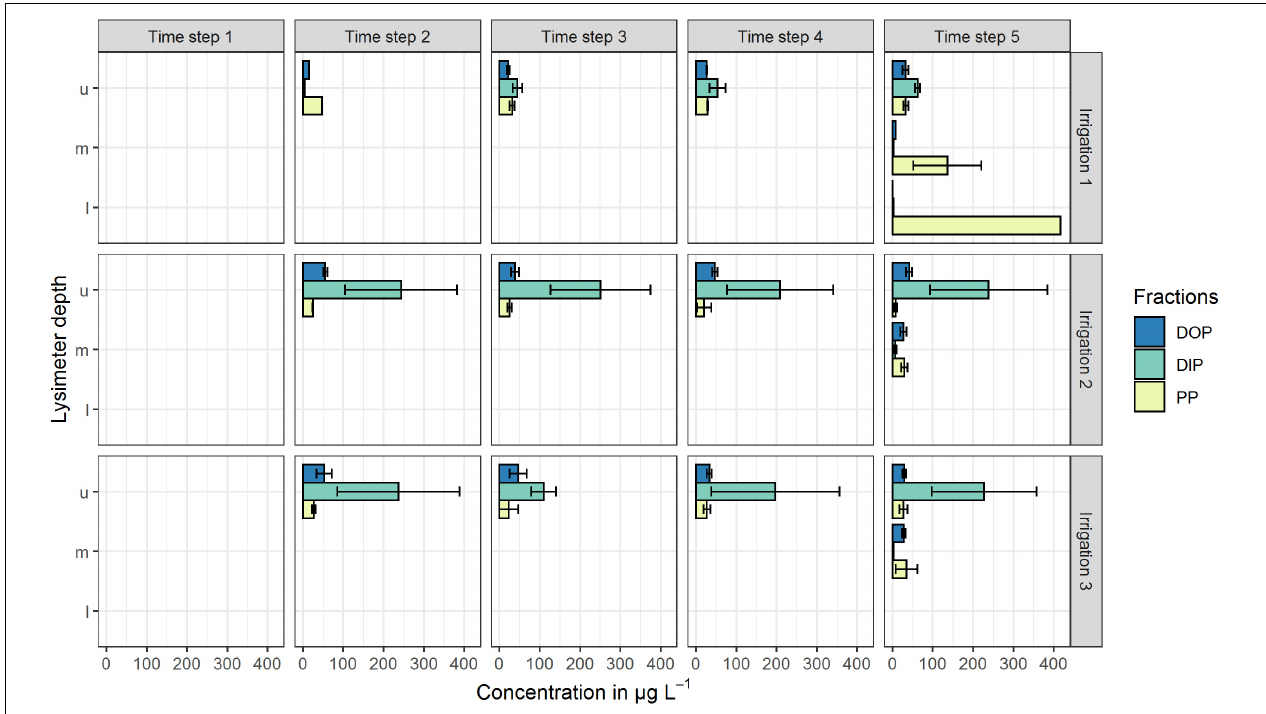
FIGURE 3 | Mean P concentrations in preferential-flow water collected with zero-tension lysimeters during three irrigations at the low P site. Arithmetic means were calculated from all samples drawn in the respective time step. Shown P fractions are DOP (dissolved organic P), DIP (dissolved inorganic P) and PP (particle bound P). Lysimeter depths are indicated by u (upper), m (middle) and l (lower). Time steps 1–4 each represent 60 min of irrigation, time step 5 represents 180 min after the end of the irrigation. No bar indicates that in the respective time step and/or depth, no sample was drawn. Error bars indicate the standard